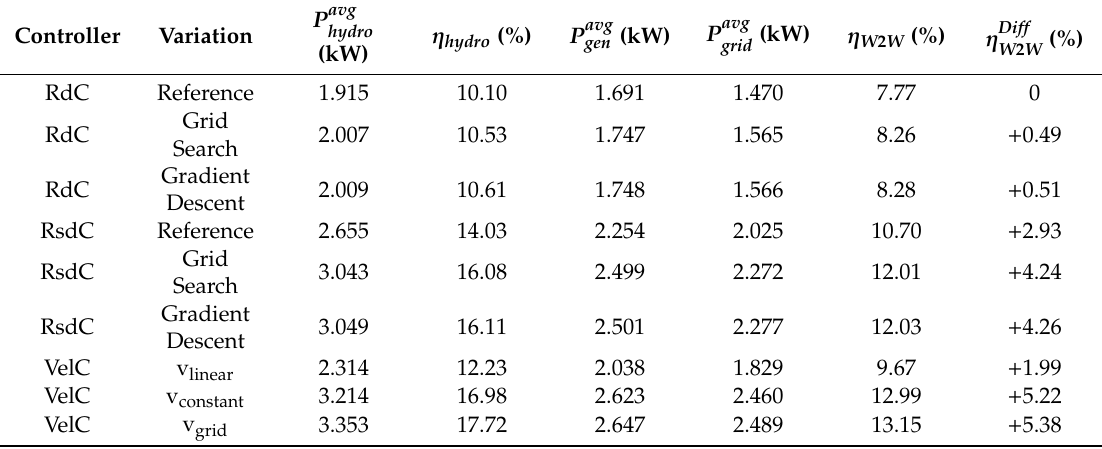
Table 8. Summary of results for all the controller options